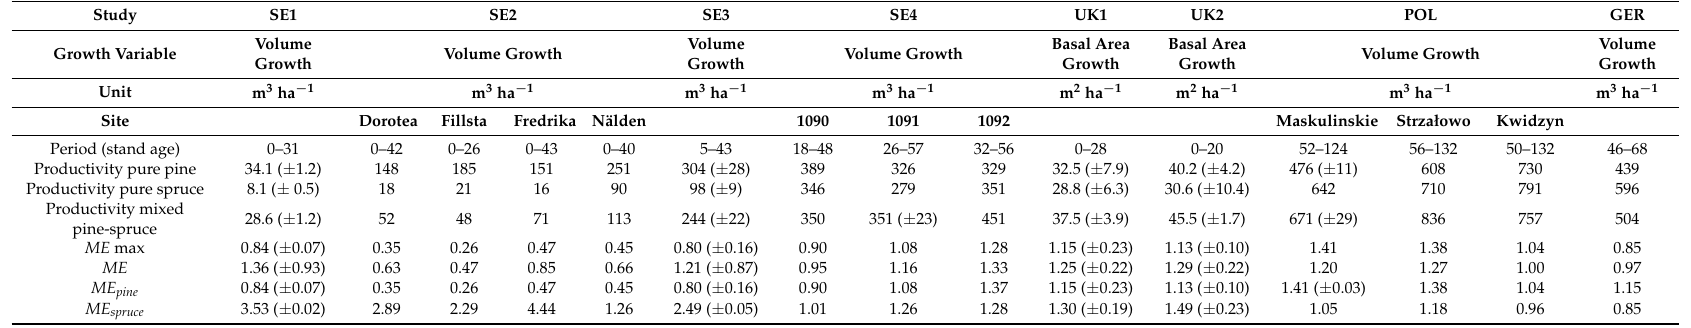
Table 4. Stand productivity (with standard deviation on site if replicated) and mixture effects ME max, ME , ME pine and ME spruce (with standard deviation if both treatments were replicated) over the entire observation period of the study sites. Grey values indicate estimated growth of pure